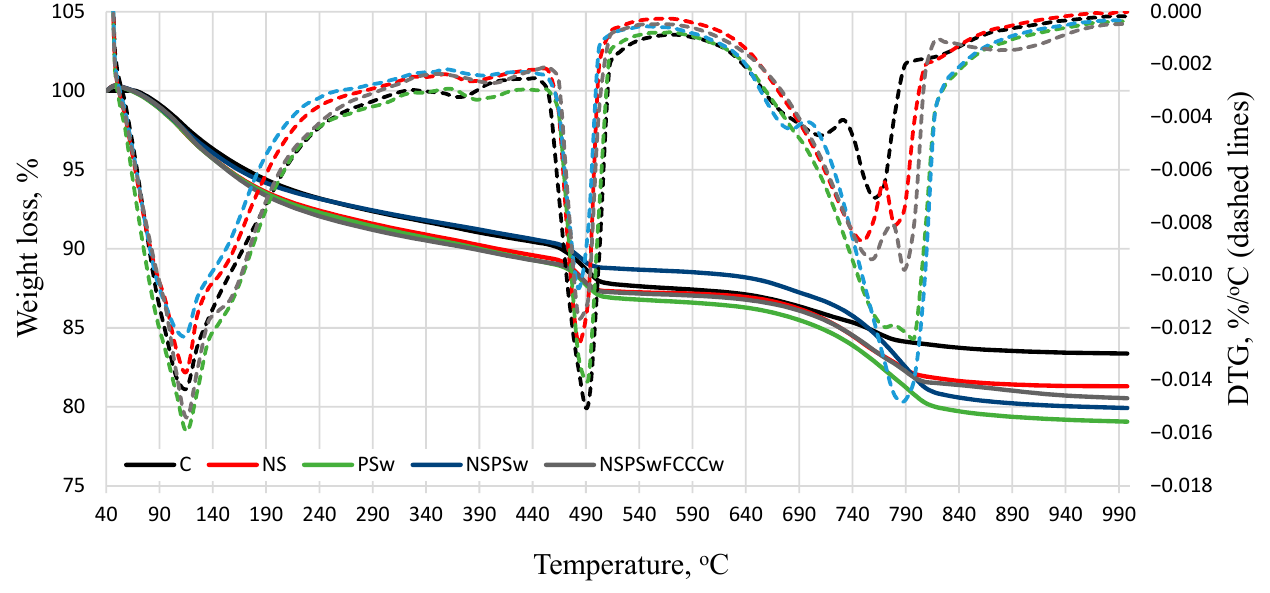
Figure 5. Results of derivative mass loss rate and cumulative mass loss at 7 days.